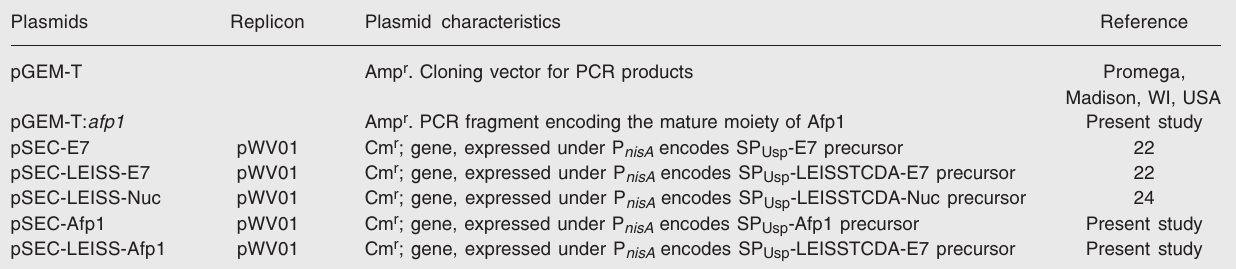
Table 1. Plasmids used in the present study.